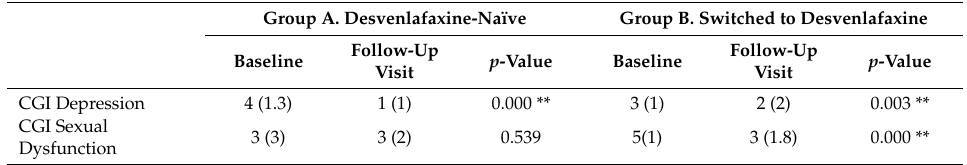
Table 3. Clinical Global Impression of Severity Scale (CGI) scores of groups A and B, comparing baseline and follow-up visit